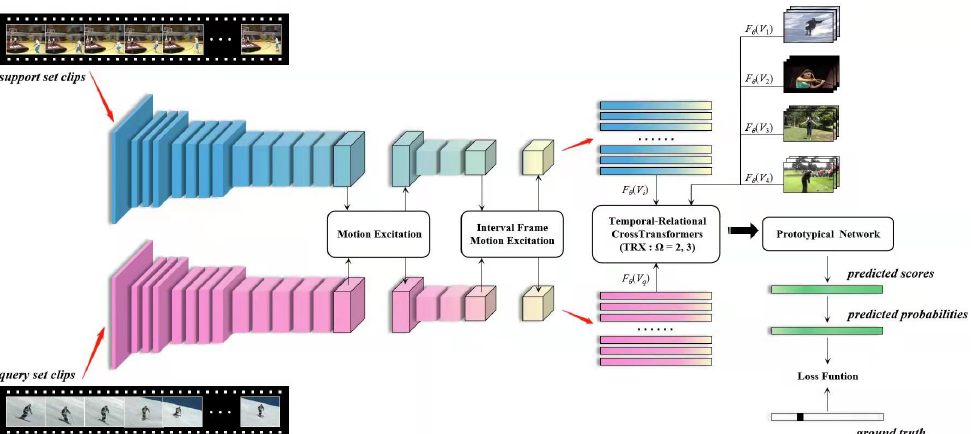
Figure 1. Schematic outline of our Hierarchical Motion Excitation Network. A task T i containing the support set and query set is extracted from total task T . The video clips are obtained from the video with the sparse temporal sampling strategy. The backbone network is composed of ResNet50 and our HME module, which includes ME and IFME. The video clips are processed by the backbone network to obtain feature F θ ( V i ) of the support set and feature F θ ( V q ) of the query set. The features at this time include feature-level motion information between video frames. When extracting features, the parameters of the backbone network are shared. The few-shot video classifier is composed of TRX and Prototype Network. F θ ( V i ) and F θ ( V q ) are processed by the classifier to obtain the predicted probabilities. We use the cross-entropy function to calculate the loss, and use SGD to complete the network